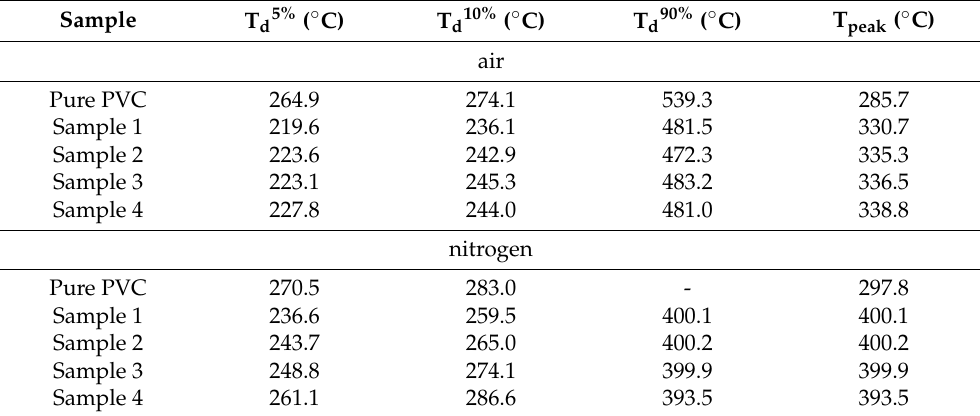
Figure 8. The TG and DTG curves of epoxidized mixed esters (Samples 1–4) and pure PVC in nitrogen. Table 6. Thermal and thermo-oxidative stability parameters of epoxidized mixed esters (Samples 1–4) and pure PVC.